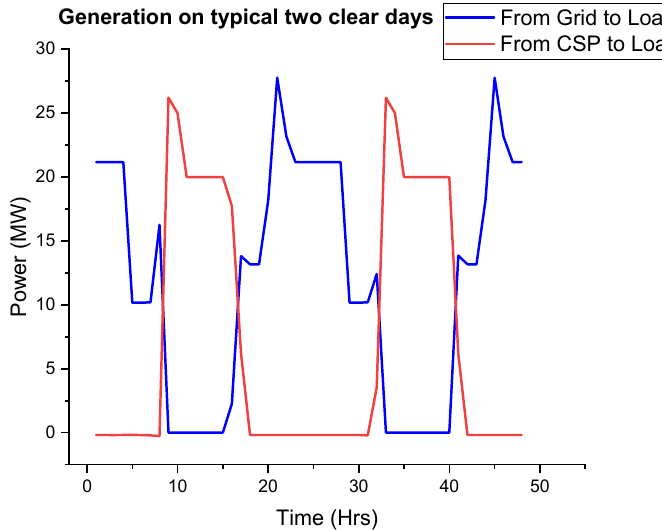
Figure 23. Two typical consecutive days with good CSP production. On a typical overcast day, as shown in Figure 24 below, the CSP system will absorb power from the grid (for auxiliary circuits) instead of generating power. The grid power will supply the load during the day and